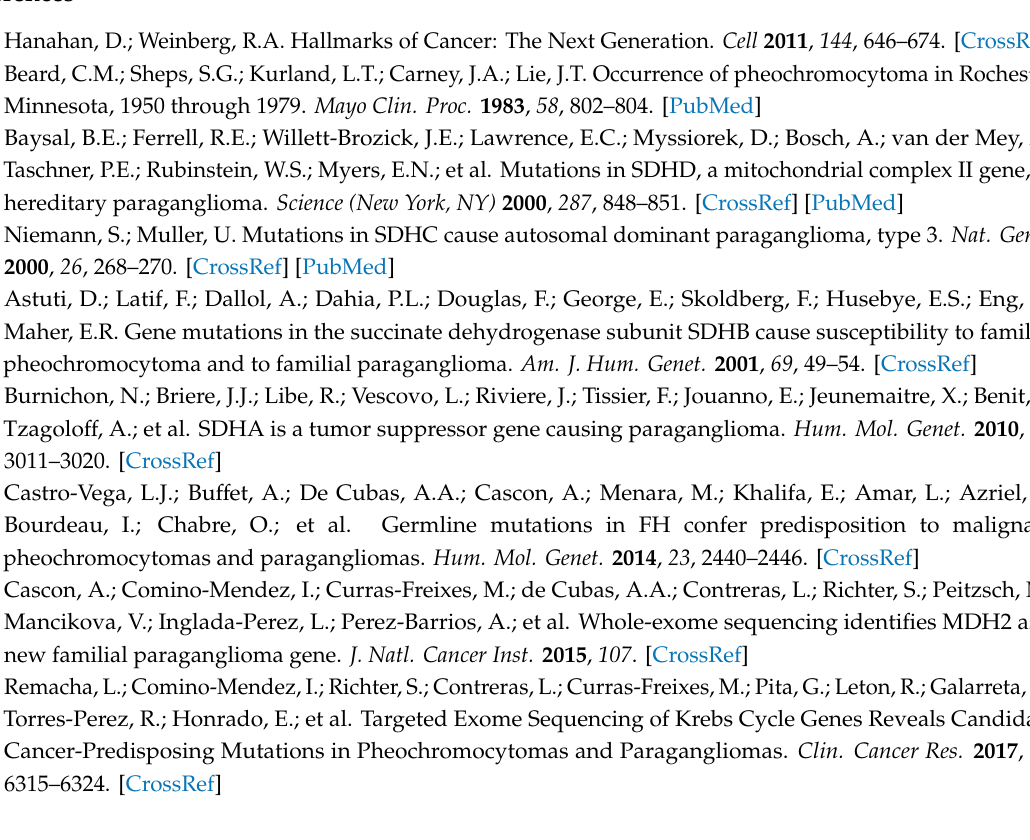
Figure S1: SDHB knockdown by Sdhb targeting siRNAs, Figure S2: Succinate to fumarate ratios in cell lines after itaconate or vehicle treatment, Figure S3: Normalized succinate levels after atpenin vs. vehicle treatment: veh: vehicle; suc: succinate, Figure S4: HeatMap, Table S1: Intracellular normalized concentrations of all measured metabolites ( µ mol / µ g), Table S2: Intracellular normalized concentrations of all measured metabolites ( µ mol / µ